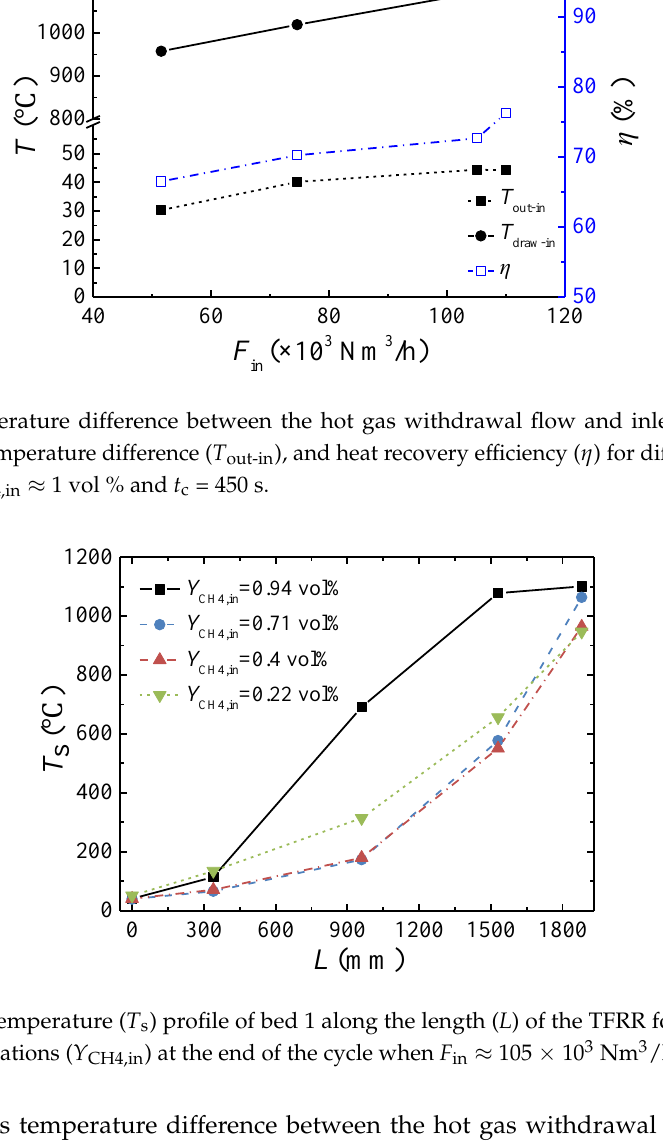
Figure 12. Solid temperature ( T s ) profile of bed 1 along the length ( L ) of the TFRR for different feed methane concentrations ( Y CH4,in ) at the end of the cycle when F in ≈ 105 × 10 3 Nm 3 /h and t c = 300 s.